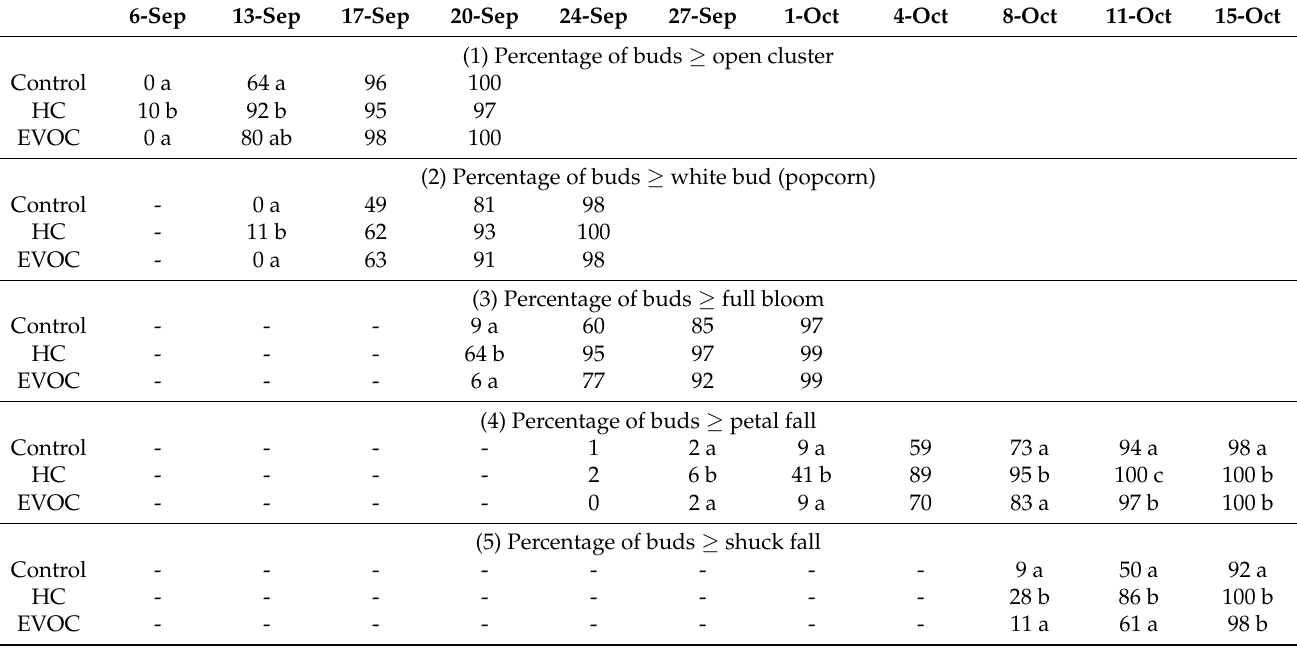
Table 3. Effect of hydrogen cyanamide (HC) and emulsified vegetable oil compound (EVOC) on the